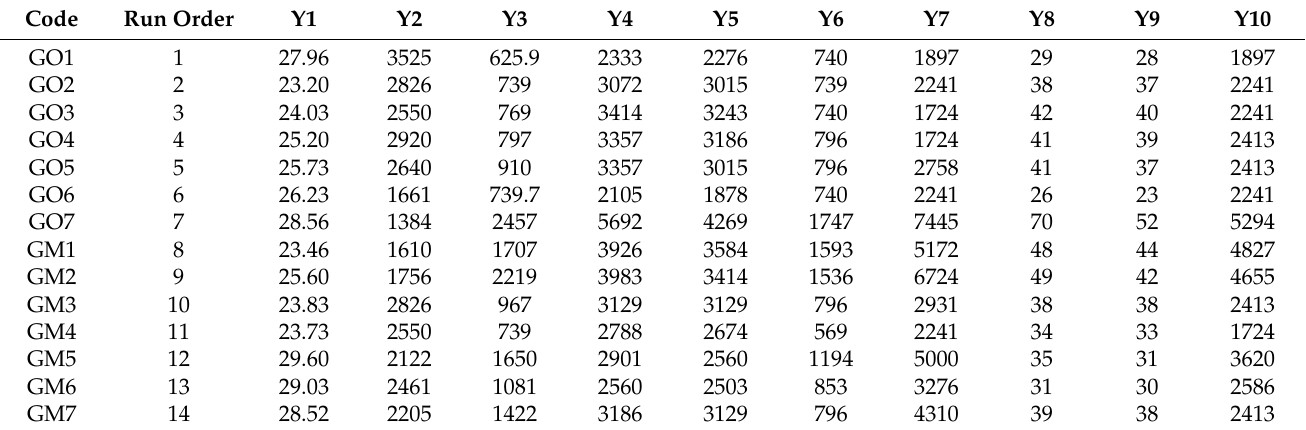
Table 4. The dependent parameters (Y1–Y10) for the 14 gel